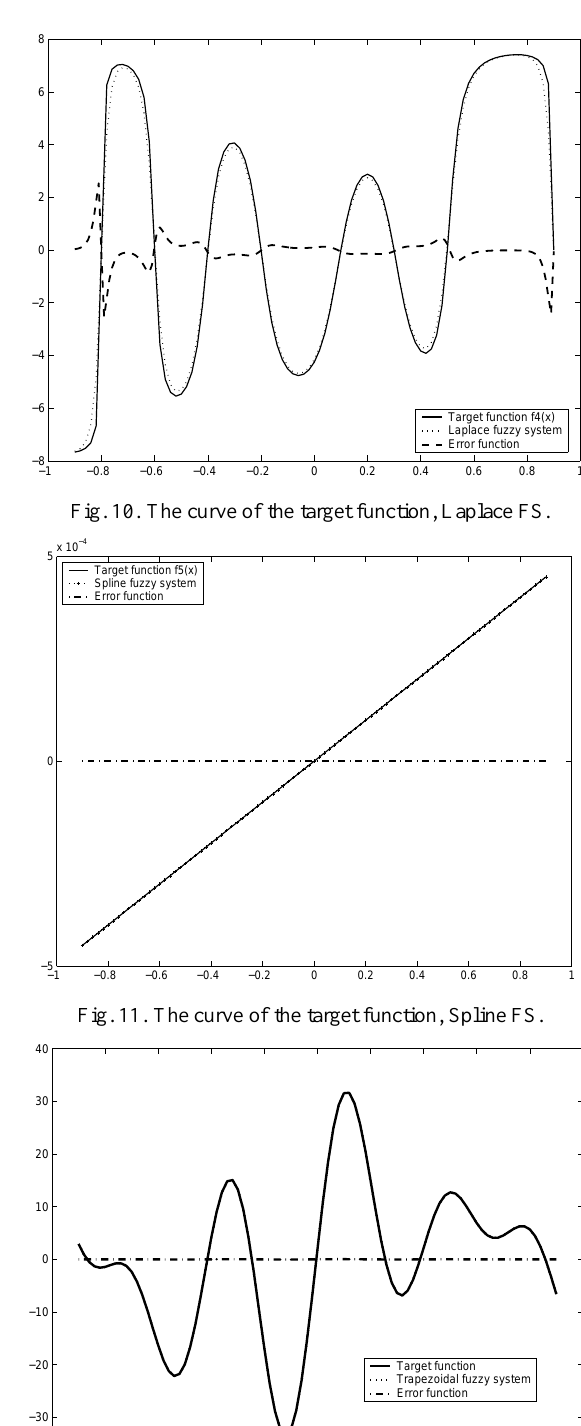
Fig. 8. The curve of the target function, Gauss FS.